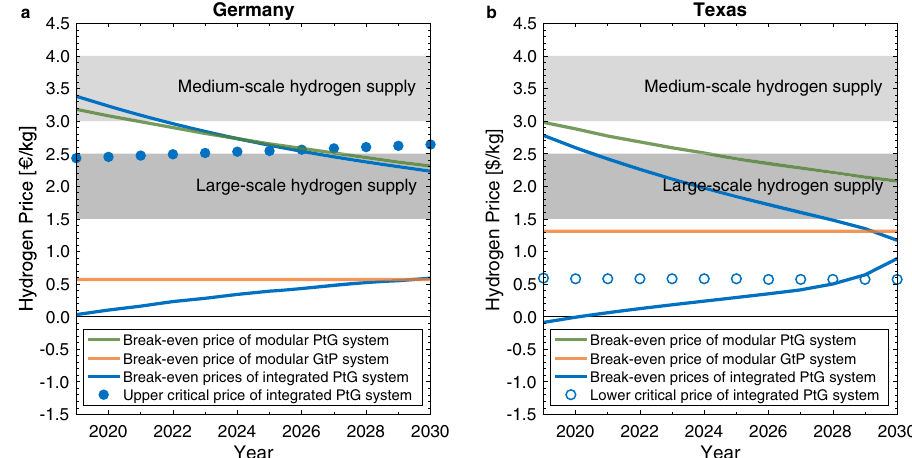
Fig. 4 Trajectory of break-even and critical hydrogen prices. This fi gure contrasts the relevant hydrogen prices of modular and integrated reversible Power-to-Gas systems in ( a ) Germany and ( b ) Texas with the hydrogen prices attained in different market segments. The lower critical price of the integrated system in Germany is consistently below − 1.5 € /kg. The upper critical price of the integrated system in Texas is consistently above 5.0